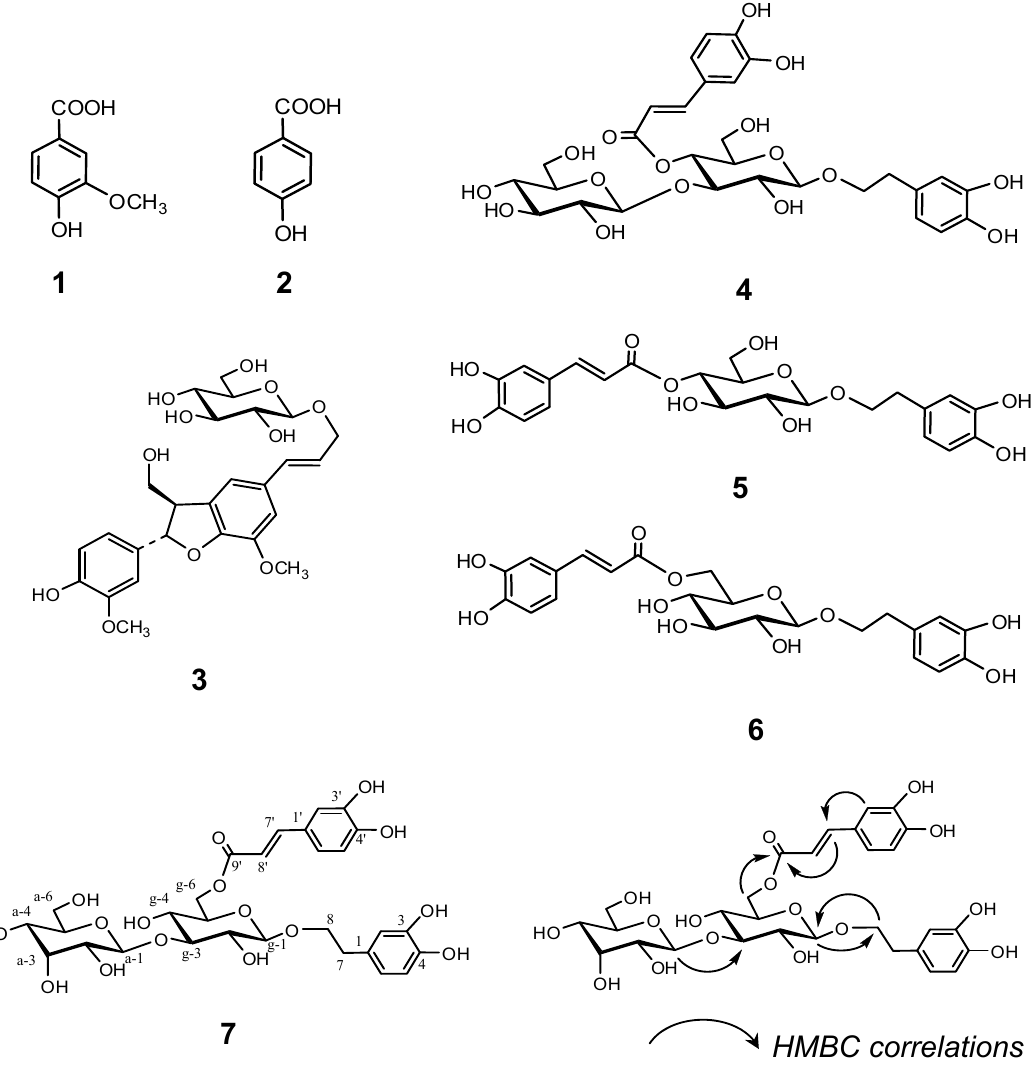
Figure 2. Structures of compounds 1 – 7 and selected HMBC correlations of 7